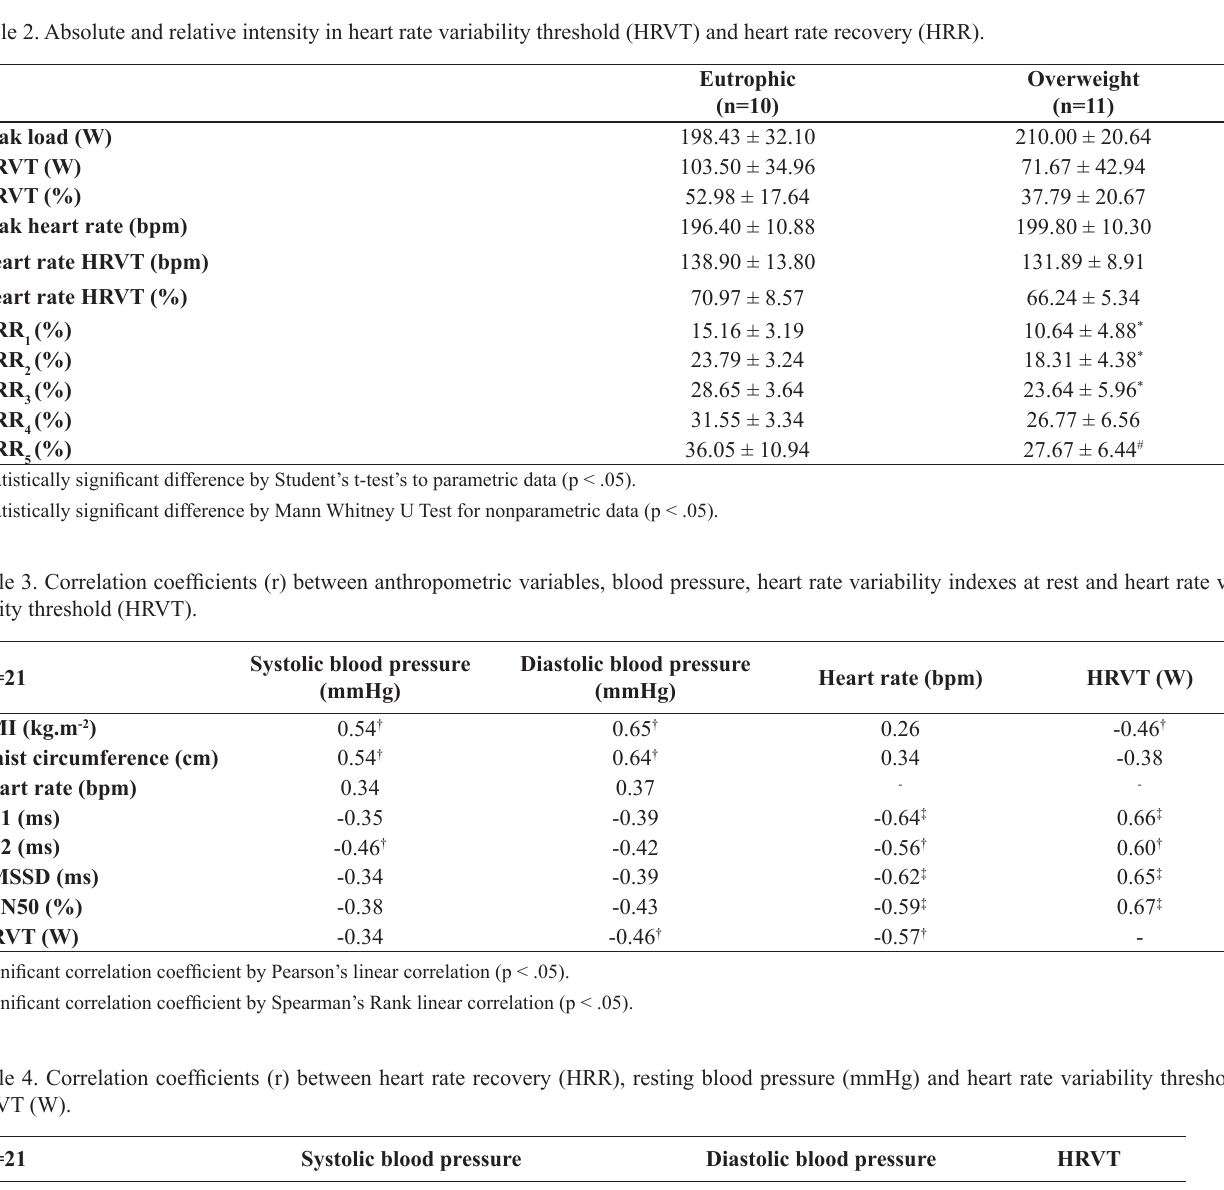
Table 2. Absolute and relative intensity in heart rate variability threshold (HRVT) and heart rate recovery (HRR).